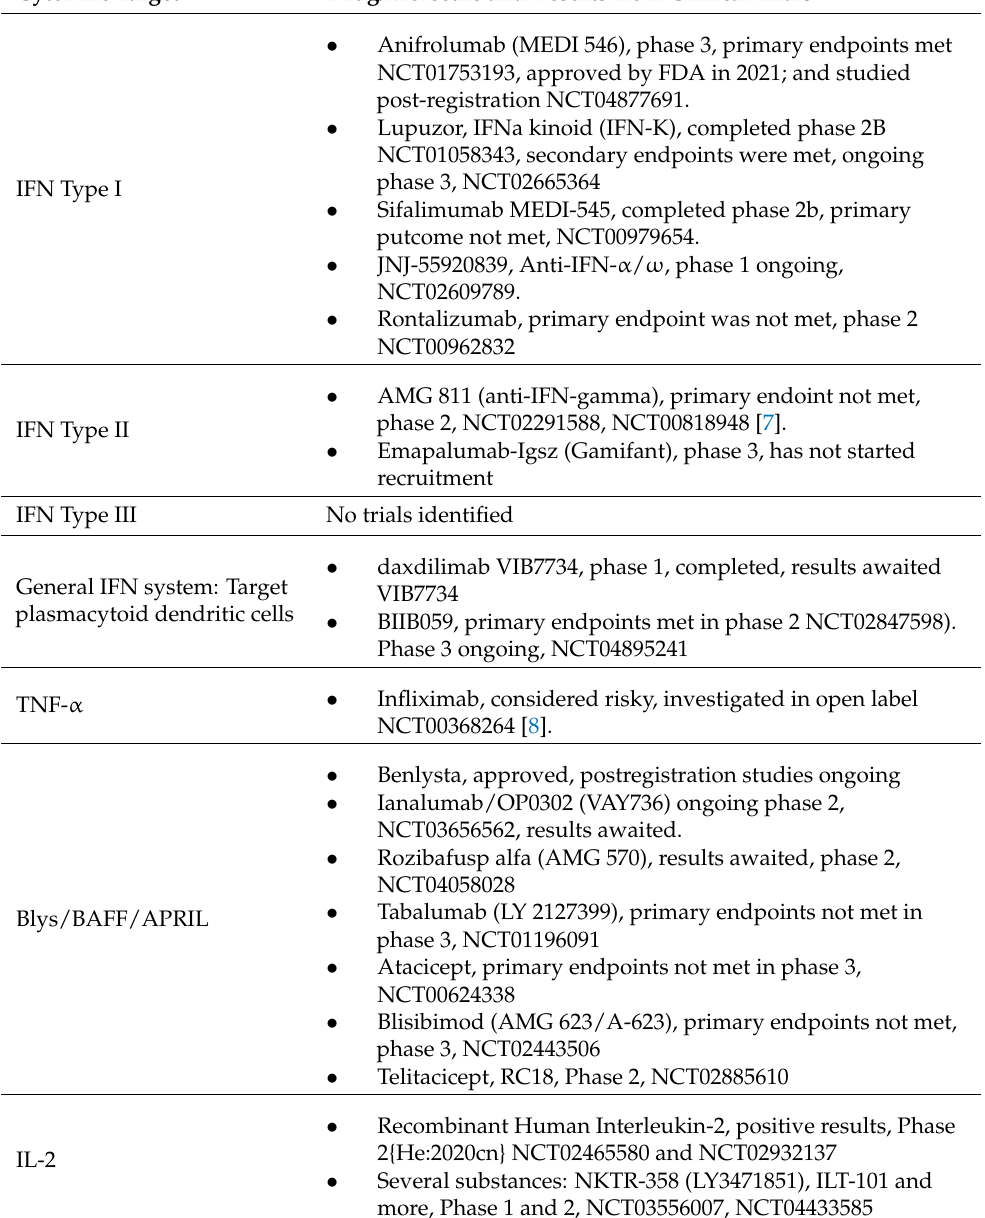
Table 2. Overview over registered therapies and ongoing trials on substances targeting cytokines as treatment targets for SLE (published or registered at www.clinicaltrials.gov, accessed on 10 October 2021. NCT number indicate registration number of clinical